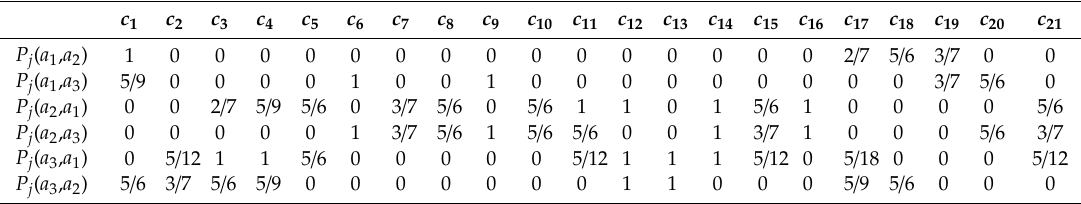
Table 3. Superiority degree for a i over a k .